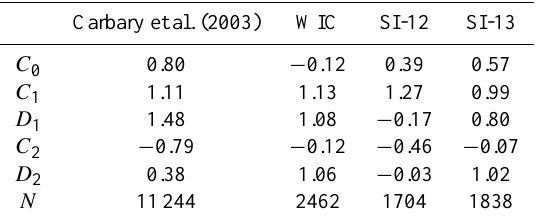
Table 1. Coefficients of the weighted second-order fit to modal latitude differences between DMSP OCB proxies and Polar UVI proxies (from Carbary et al., 2003) and IMAGE FUV OCB proxies. N is the number of OCB proxies compared in each